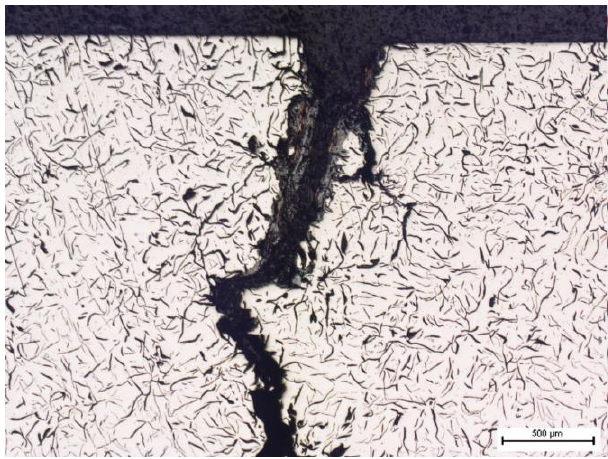
Fig. 6. Microscopic image of the analyzed brake disc. The visible crack spreads along the entire cross-section of the disc; unetched state, light microscopy